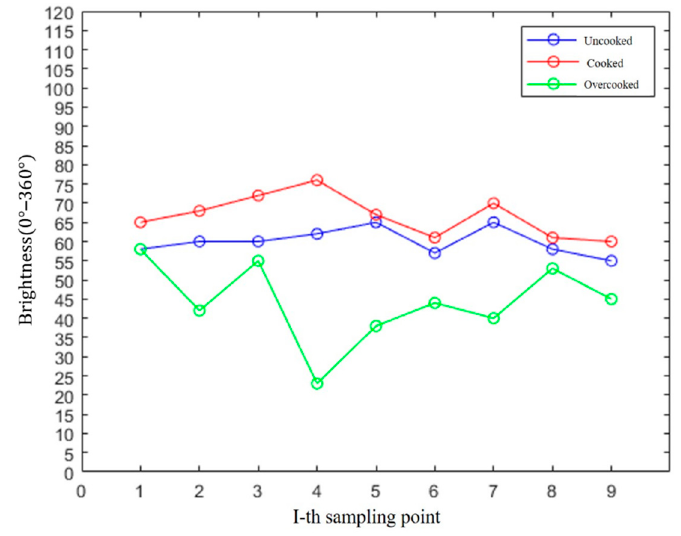
Figure 12. The brightness changes in the nine marking points.